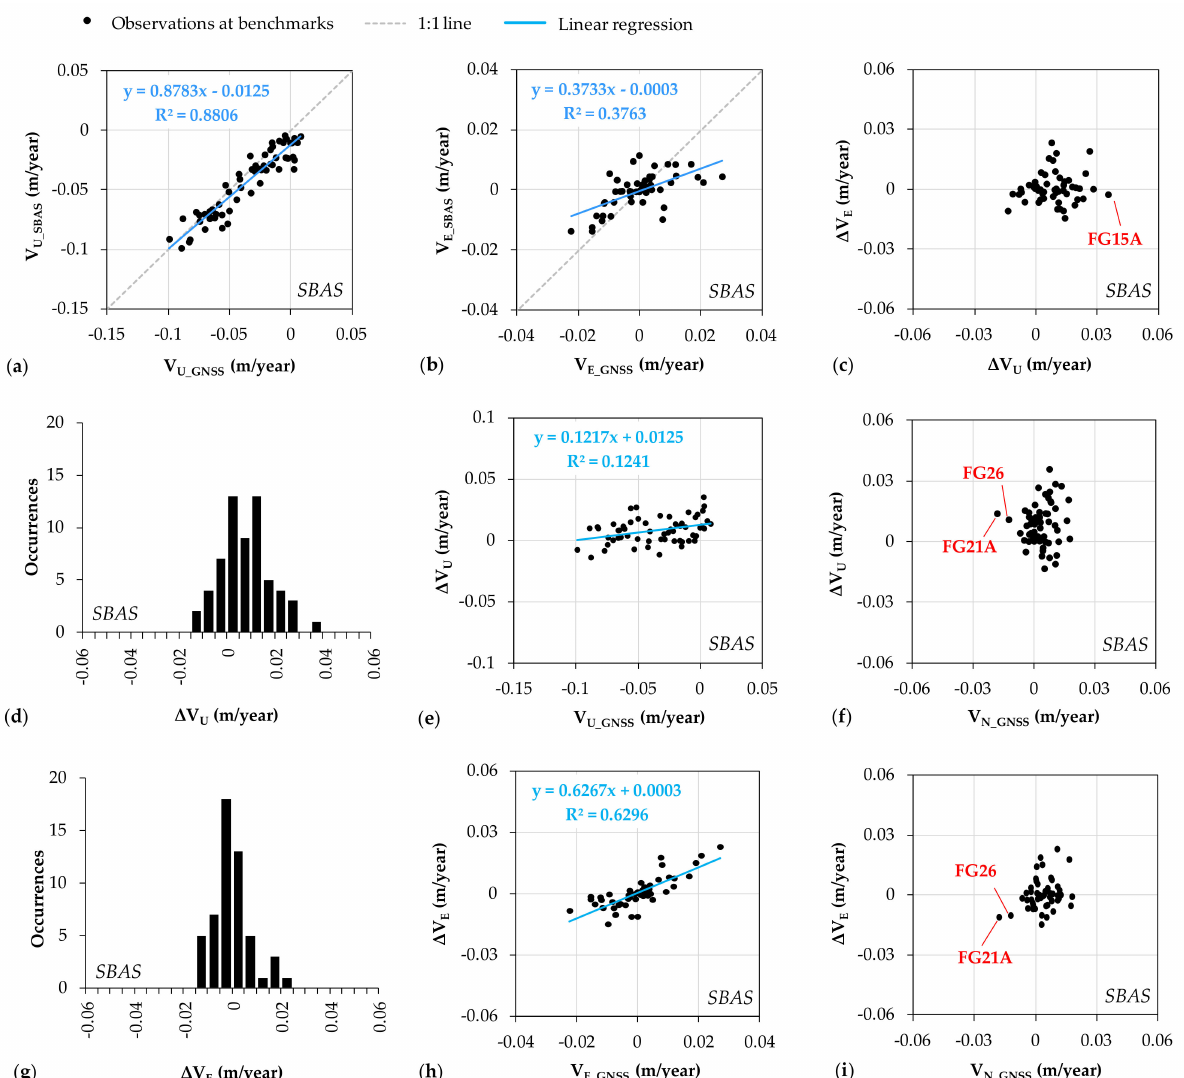
Figure 14. Comparison of the displacement velocity along the ( a ) vertical V U and ( b ) east-west V E direction as estimated from the SBAS InSAR analyses and recorded at the permanent GNSS stations and GNSS benchmarks. The observed differences ∆ V U and ∆ V E are further investigated through ( c ) inter-comparison, ( d , g ) analysis of the respective histograms, and ( e , f , h , i ) their distribution in relation to GNSS